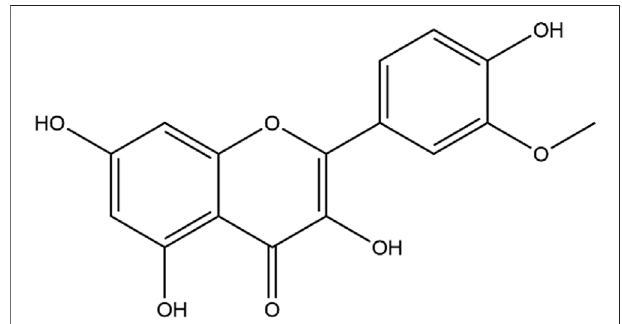
FIGURE 1 | Chemical structure of